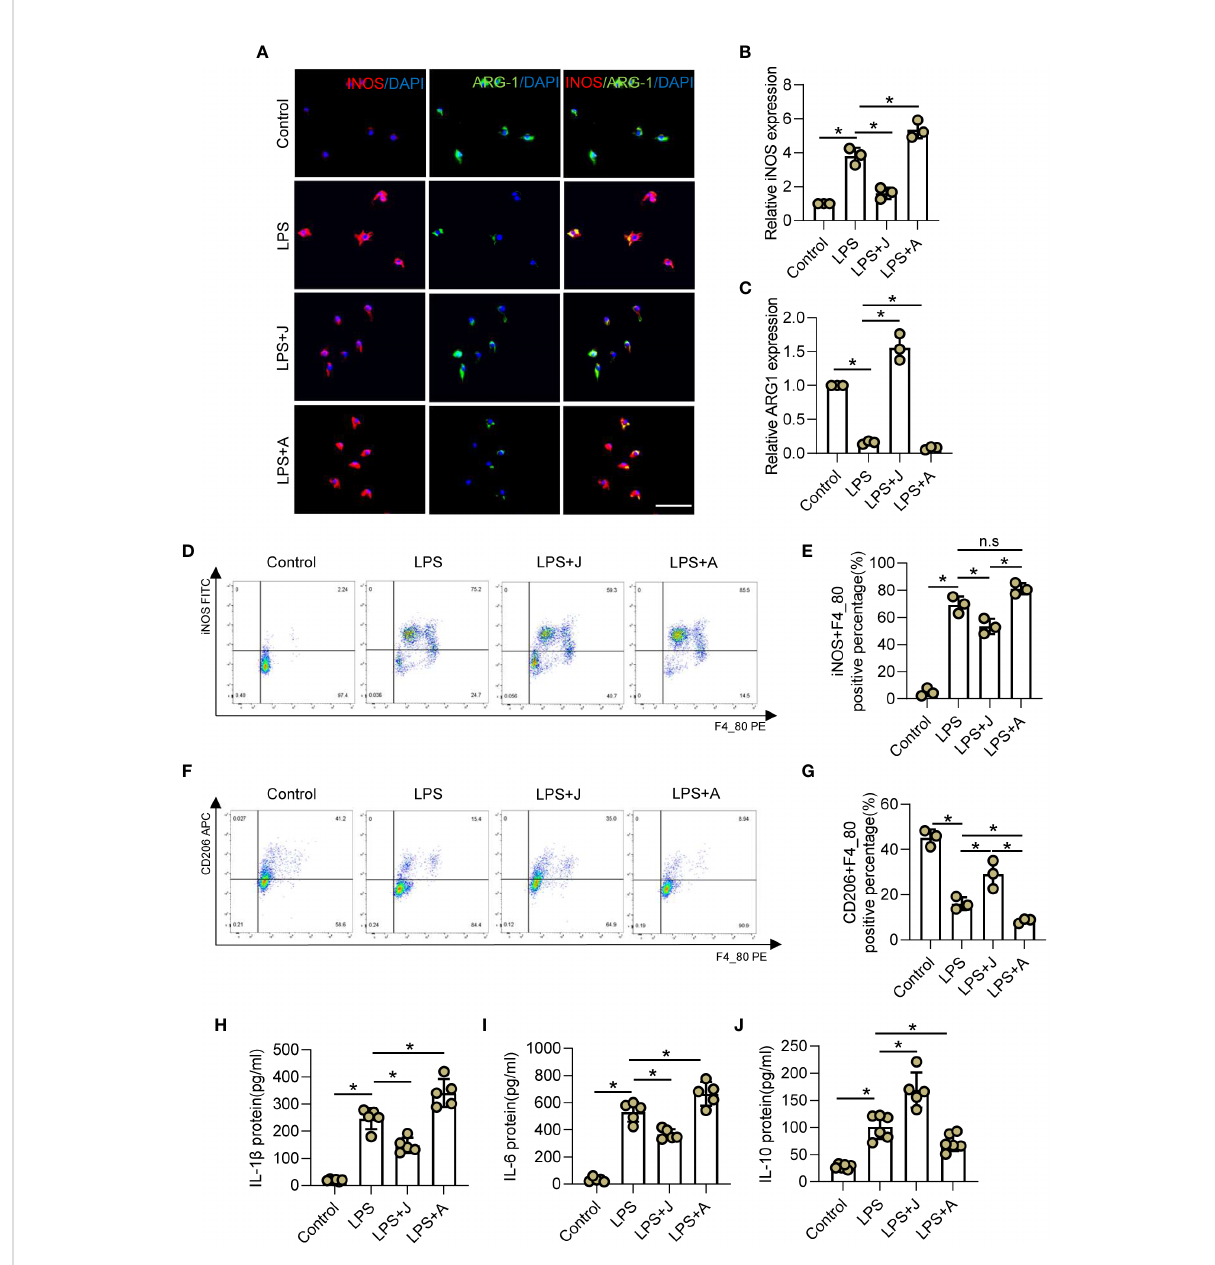
FIGURE 2 CB2R regulates in fl ammation-mediated polarization of microglia. (A) IF staining of iNOS (red) and ARG-1 (green) in BV2 microglia after LPS insult for 24 h with CB2R activation by JWH-133 (J) or inactivation by AM630 (A) . Scale bar = 50 m m. (B) Quantitative analysis indicating that CB2R signi fi cantly altered expression of the M1 marker iNOS during in fl ammation. (C) Quantitative analysis indicating that CB2R signi fi cantly altered expression of the M2 marker ARG-1 after LPS stimulation. (D) Flow cytometry results showing the relative proportion of M1 microglia (red) after LPS insult with and without CB2R activation or inactivation. (E) Quantitative analysis of M1 microglia. (F) Flow cytometry results showing the relative proportion of M2 microglia (red) after LPS insult with and without CB2R activation or inactivation. (G) Quantitative analysis of M2 microglia. ELISA results of IL-1 b (H) , IL-6 (I) , and IL-10 (J) in the control, LPS, LPS+J (JWH-133), and LPS+A (AM630) groups. * p < 0.05. n.s means no signi fi